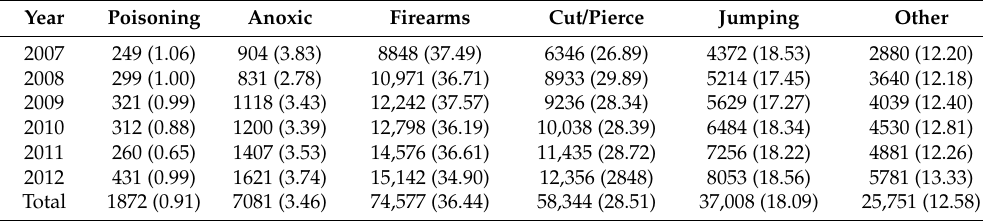
Table 2. Trend of methods to do self-inflicted harm from 2007 to 2012.